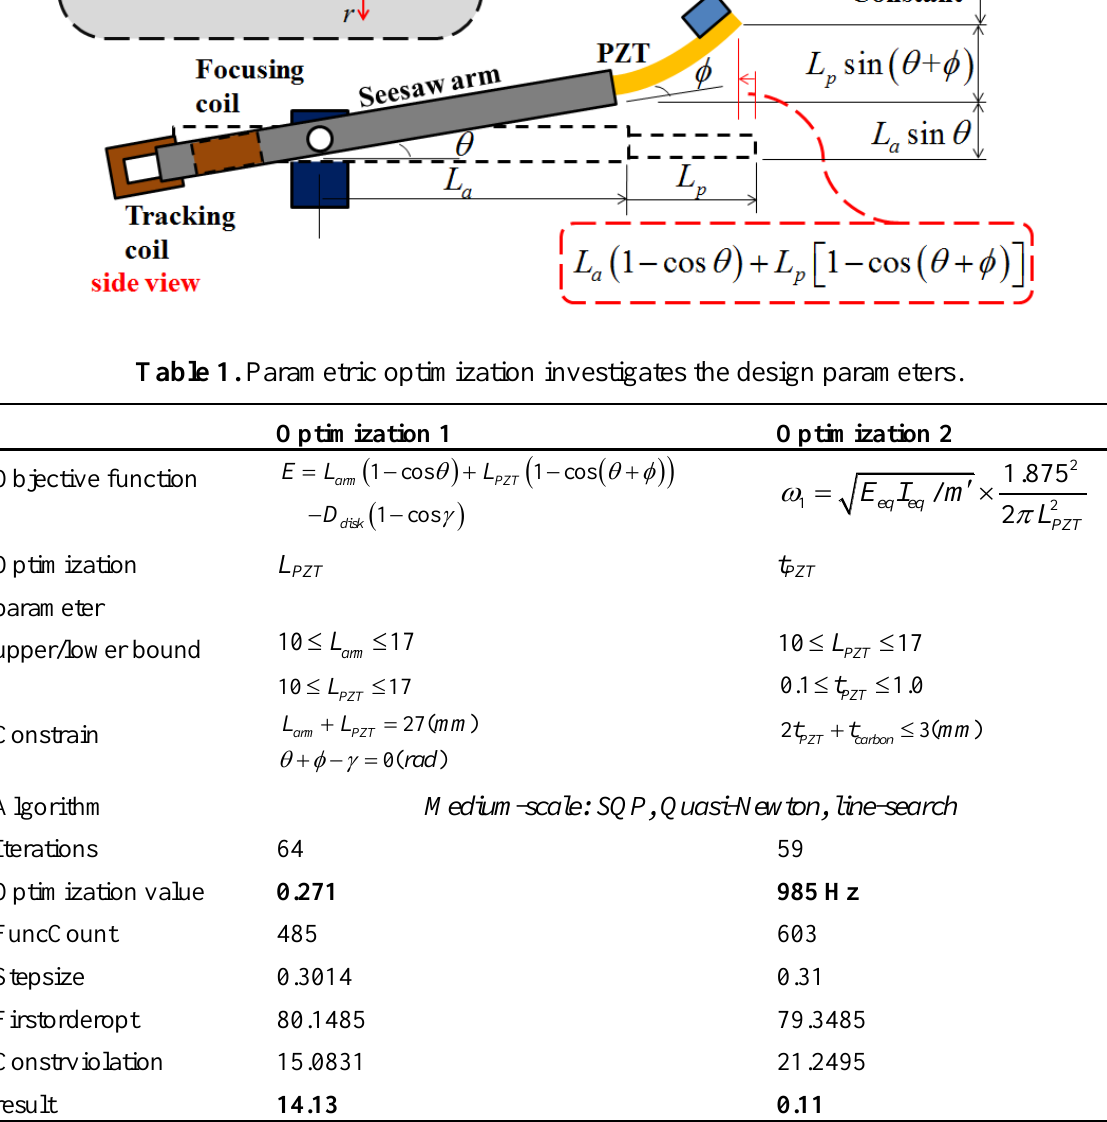
Medium-scale: SQP, Quasi-Newton,